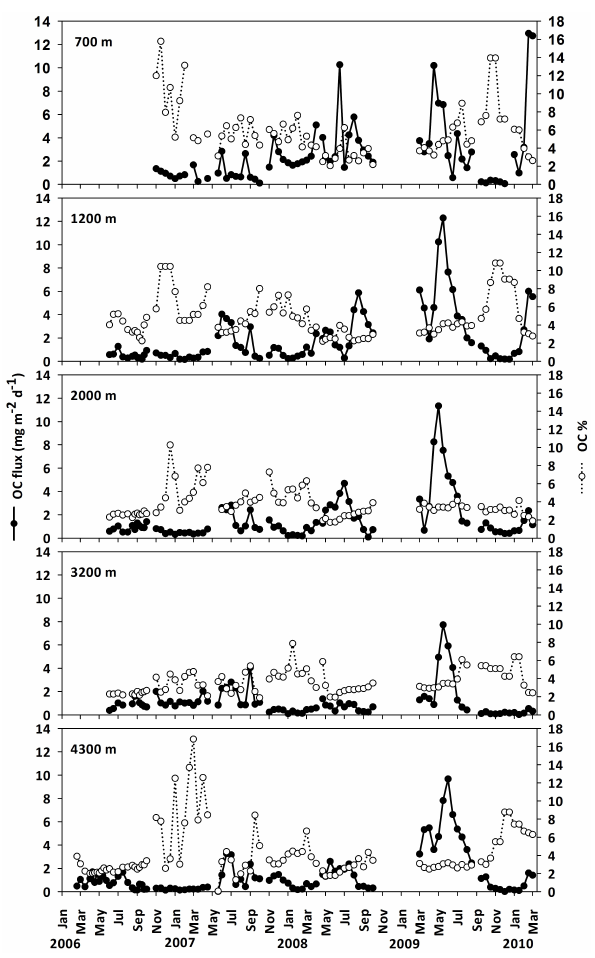
Fig. 7. Time-series plots of carbonate content (%) and fluxes (mgm − 2 d − 1 ) of downward settling particles collected by sediment traps during the course of the long-term experiment in NESTOR